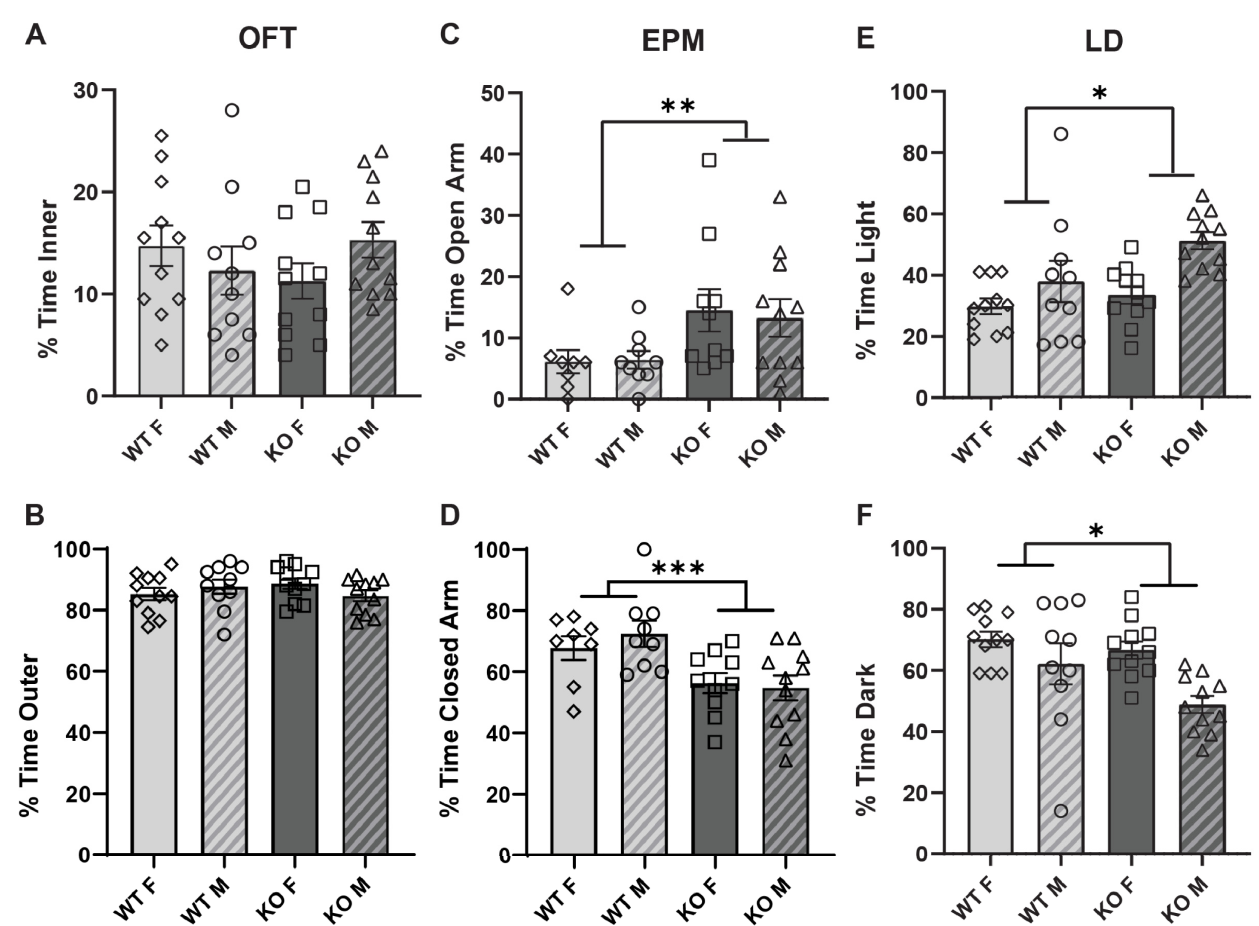
Fig 3. α 2 δ -4 KO mice exhibit diminished anxiety-like behaviors. For WT and α 2 δ -4 KO mice, graphs show the % total time spent in the inner and outer regions of the chamber in the open field test (OFT) (A,B), open and closed arms of the elevated plus maze (EPM) (C,D), and light and dark chambers in the light-dark assay (LD) (E,F). � p < 0.05; �� p < 0.01; ��� p < 0.001 by Kruskal-Wallis and linear mixed model.